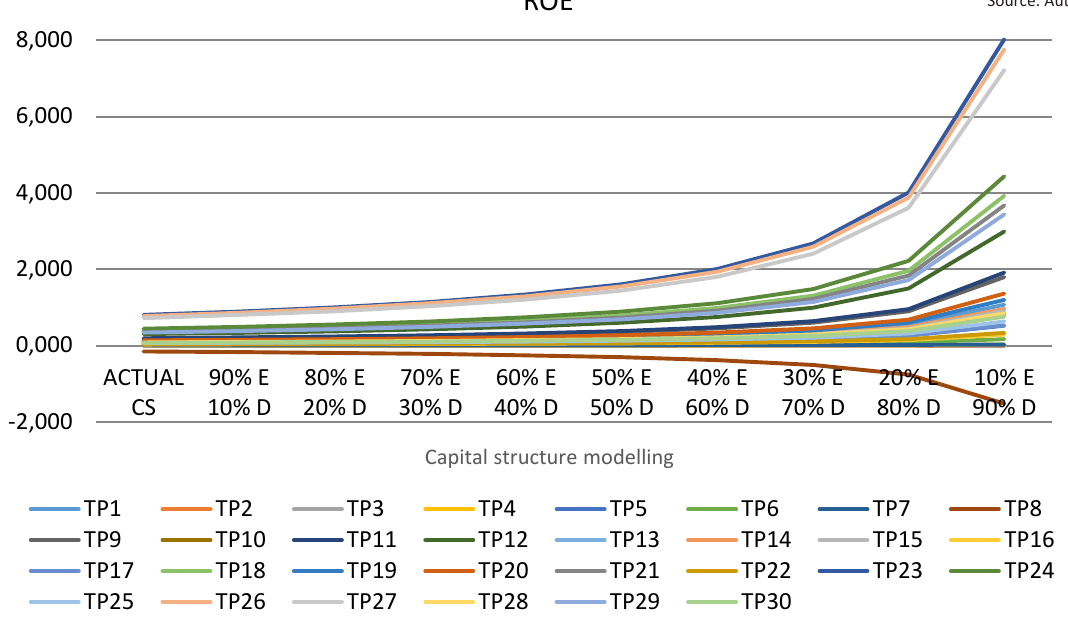
Figure 6. Development of return on